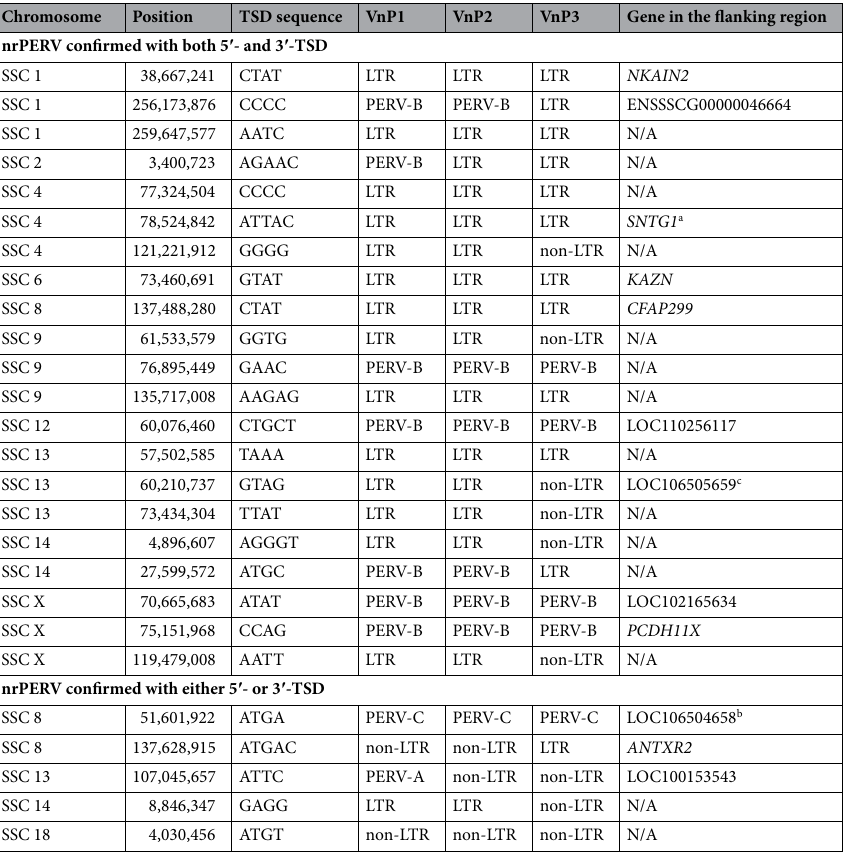
Table 1. Detected target site duplication (TSD) position and sequences. Chromosome number and position are based on the Sscrofa11.1 reference genome. Gene symbols are as follows: NKAIN2 , Na + /K + transporting ATPase interacting 2; ENSSSCG00000046664, lncRNA; SNTG1 , syntrophin gamma 1; KAZN , kazrin, periplakin interacting protein; CFAP299 , cilia and flagella associated protein 299; ANTXR2 , anthrax toxin receptor 2; LOC110256117; mRNA-multidrug and toxin extrusion protein 1-like, transcript variant; LOC100153543, multiple epidermal growth factor-like domains protein 10-like (predicted); PCDH11X , protocadherin 11 X-linked. LOC102165634, LOC106504658, and LOC106505659 are uncharacterized genes. N/A, not applicable. a TSD position is 2.5 kb downstream of the gene. b TSD position is 25 kb downstream of the gene. c TSD position is 16 kb downstream of the